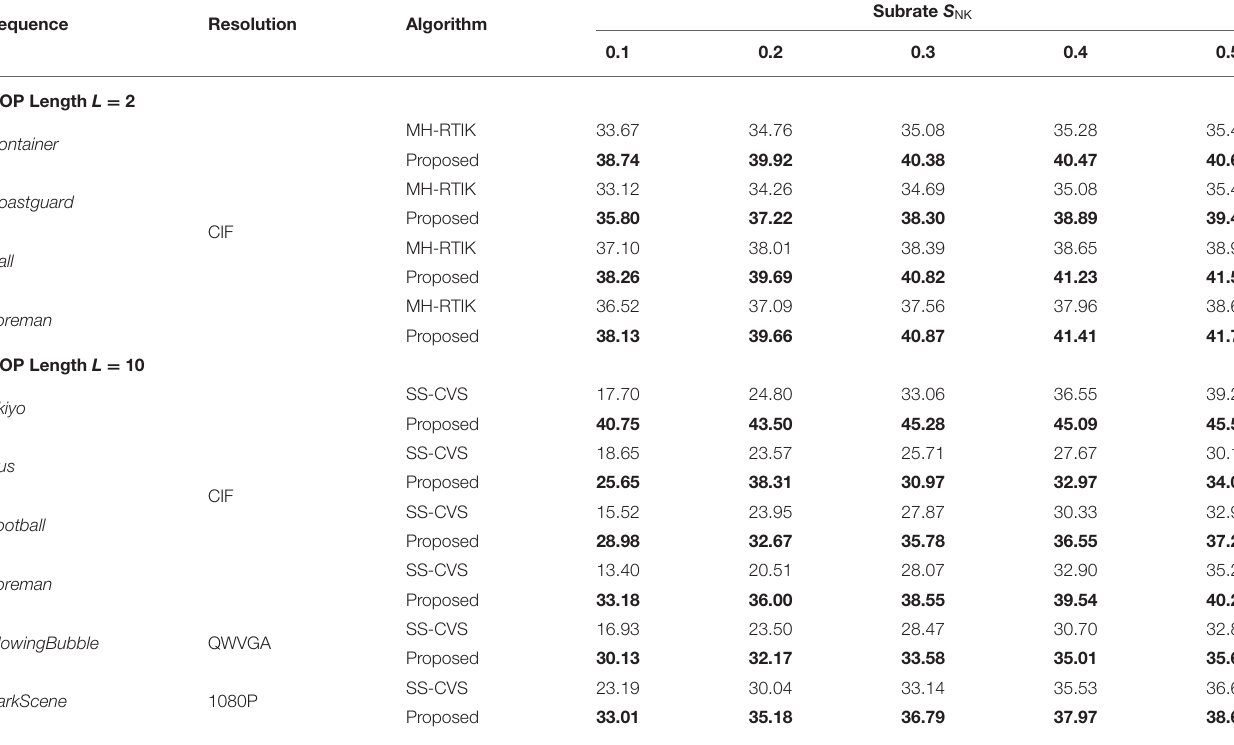
TABLE 1 | Average Peak Signal-to-Noise Ratio (PSNR) (dB) for reconstructed video sequences by the proposed Compressive Video Sensing (CVS) system, Scalable Structured CVS (SS-CVS) (Trevisi et al., 2020), and Multi-Hypothesis Reweighted TIKhonov (MH-RTIK) (Chen C. et al., 2020) at subrates 0.1 to 0.5.